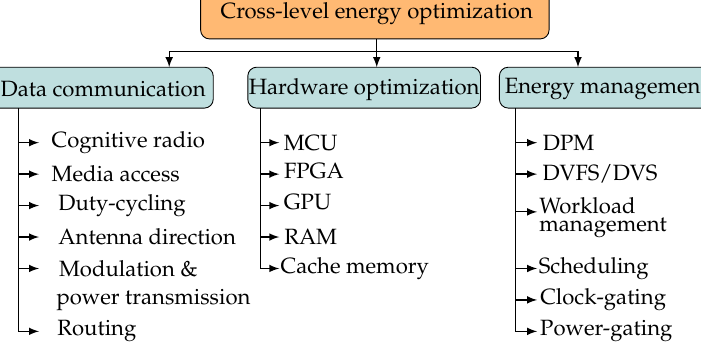
Figure 1. Cross-level energy optimization